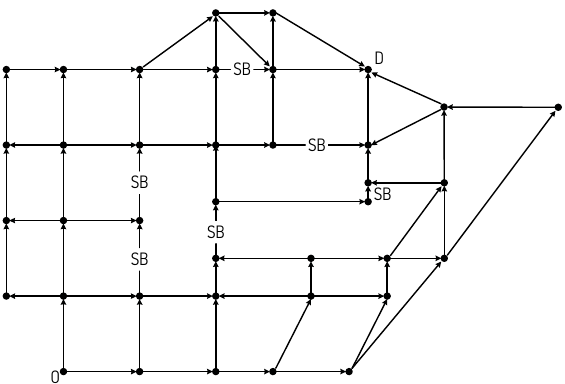
Fig. Network for experimental design (Frejinger et al.